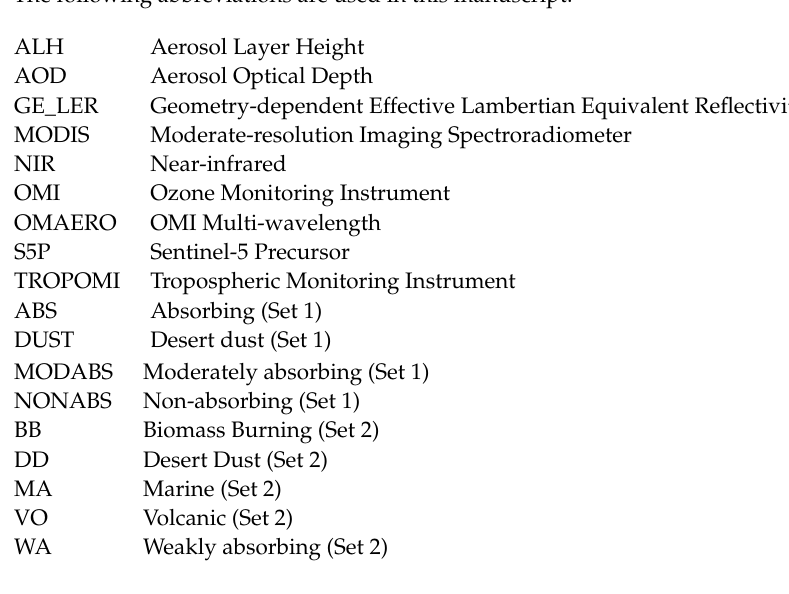
The aerosol model with the highest evidence from Set 1, and (b) the aerosol type containing the aerosol model with the highest evidence from Set 2. The TROPOMI spectra were recorded on 6 June 2020. Figure S3: The model evidence for each aerosol model from Set 1. The TROPOMI spectra were recorded on 6 June 2020. Figure S4: The sum of the first 10 best aerosol model evidences for each aerosol type from Set 2. The TROPOMI spectra were recorded on 6 June 2020. Figure S5: The maximum solution estimates ( h max , τ max ) and the mean solution estimates ( h mean , τ mean ) for Set 1 and data on 6 June 2020. Figure S6: The same as in Figure S5 but for Set 2. Figure S7: True-color VIIRS image recorded on 10 February 2020. Figure S8: (a) The aerosol model with the highest evidence from Set 1, and (b) the aerosol type containing the aerosol model with the highest evidence from Set 2. The TROPOMI spectra were recorded on 10 February 2020. Figure S9: The model evidence for each aerosol model from Set 1. The TROPOMI spectra were recorded on 10 February 2020. Figure S10: The sum of the first 10 best aerosol model evidences for each aerosol type from Set 2. The TROPOMI spectra were recorded on 10 February 2020. Figure S11: The maximum solution estimates ( h max , τ max ) and the mean solution estimates ( h mean , τ mean ) for Set 1 and data on 10 February 2020. Figure S12: The same as in Figure S11 but for Set